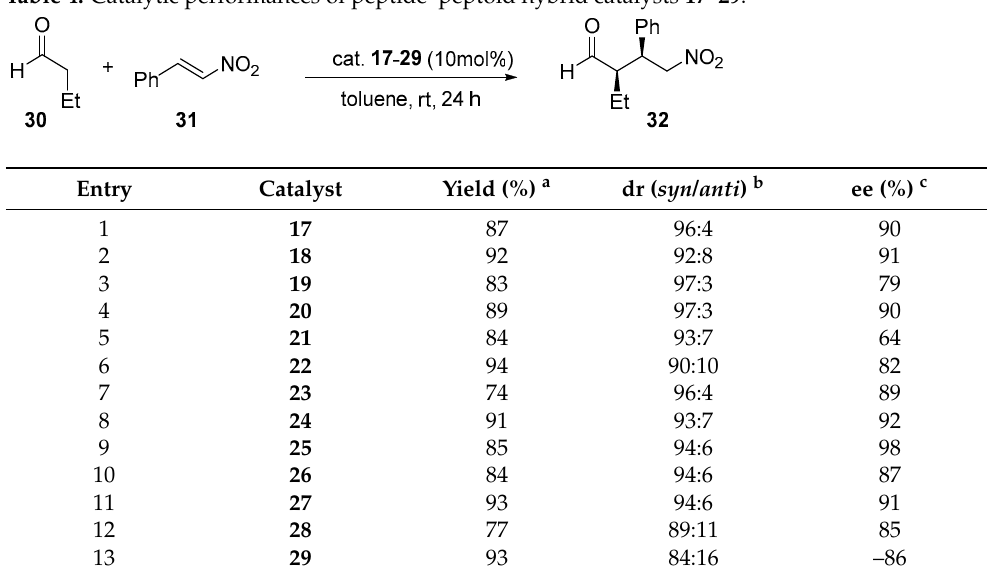
Table 4. Catalytic performances of peptide–peptoid hybrid catalysts 17 – 29 .